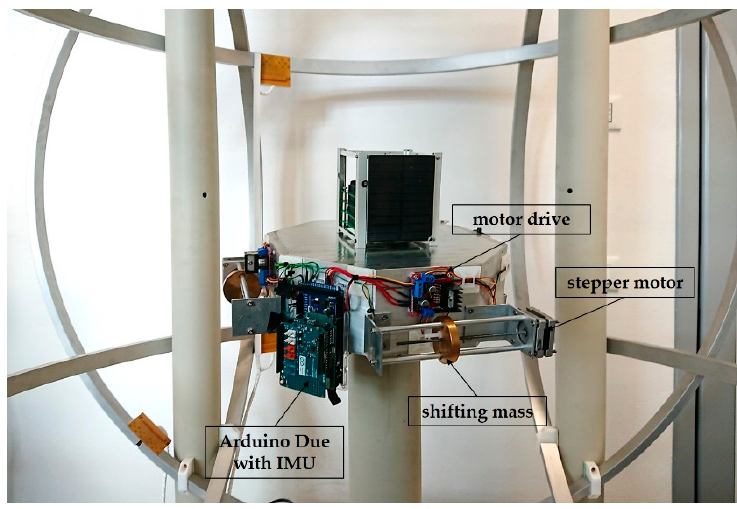
Figure 7. The articulated stand, equipped with the custom ABS, hosting a 1U CubeSat mock-up, used for the experimental verification.